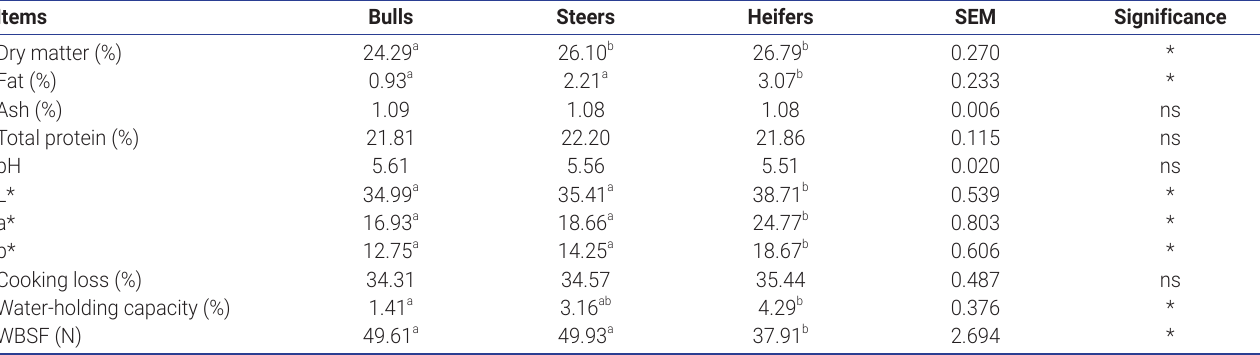
Table 4. Chemical composition and physical properties of m. longissimus thoracis Items